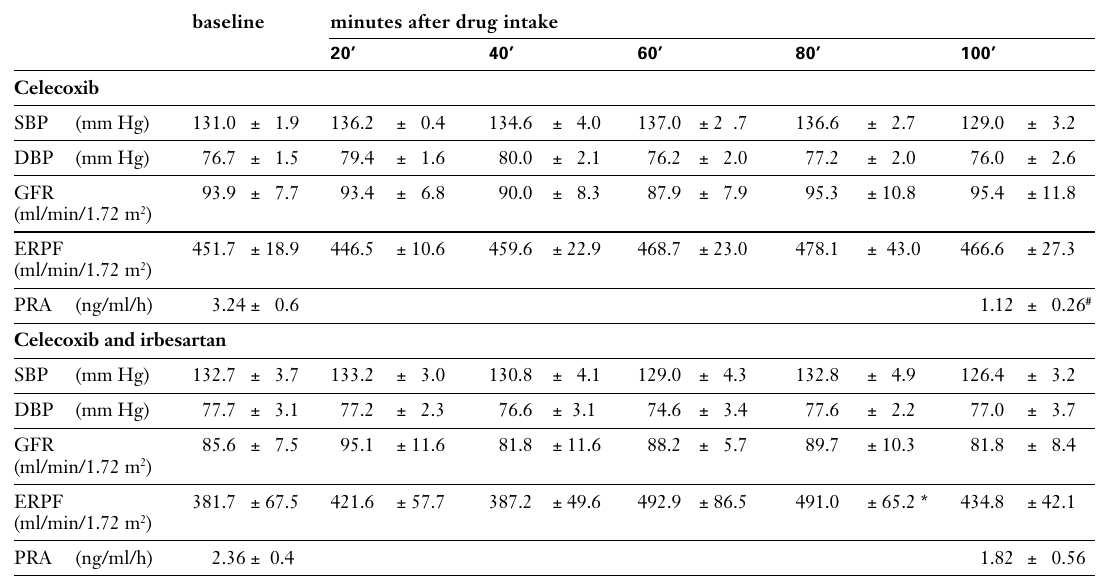
Clinical, renal and metabolic character- istics of the subjects during the two study